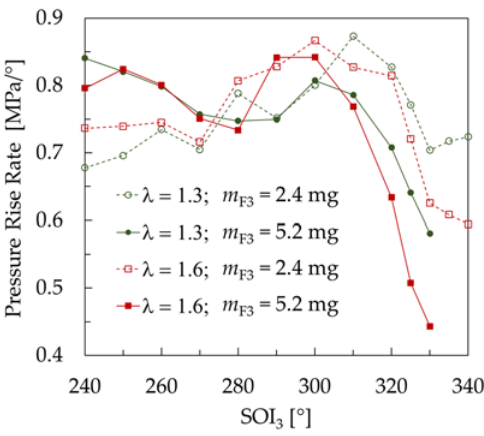
Figure 7. Pressure rise rate versus SOI 3 timing for all investigated conditions.